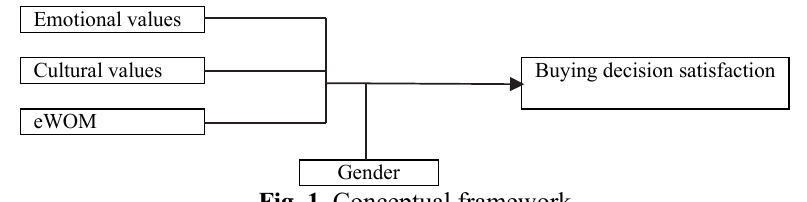
Fig. 1. Conceptual